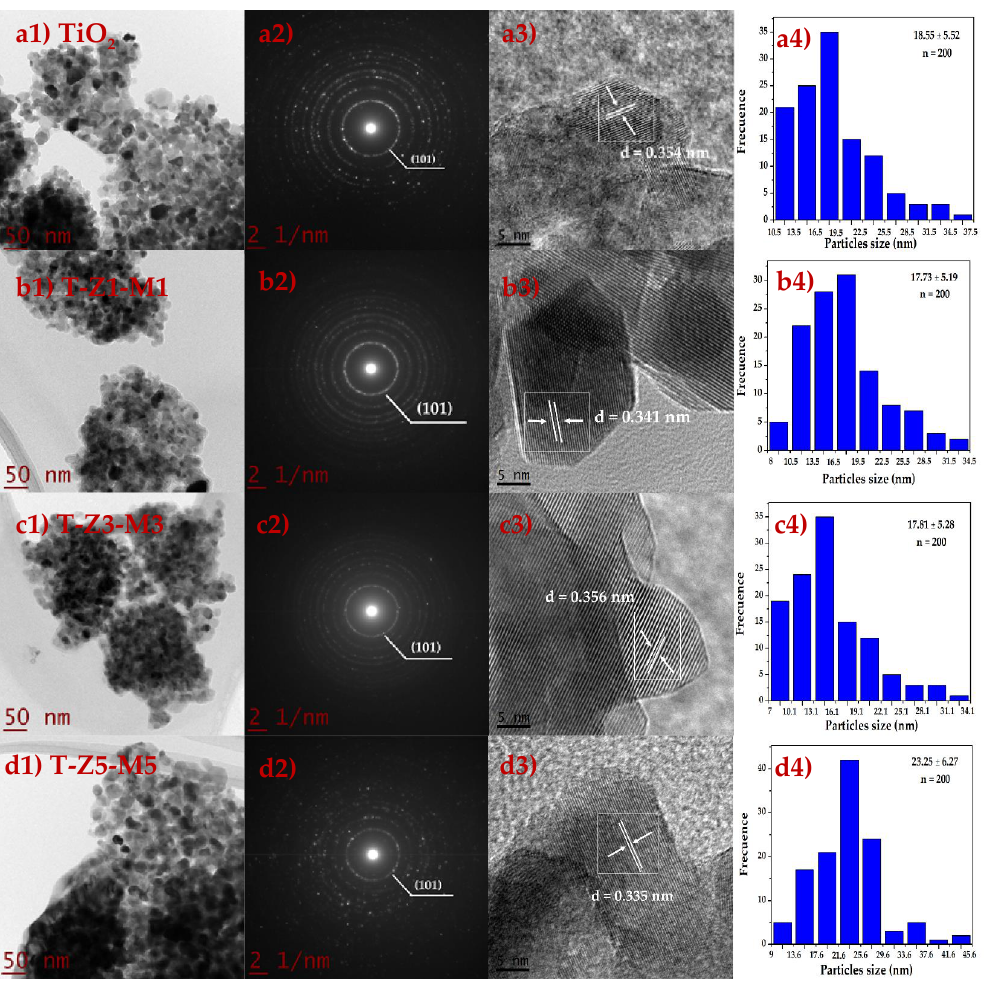
Figure 1. Transmission electron microscopy ( a1 , b1 , c1 , d1 ), selected area electron di ff raction pattern ( a2 , b3 , c2 , d2 ), high-resolution transmission electron microscope ( a3 , b3 , c3 , d3 ) and the size distribution ( d1 , d2 , d3 , d4 ) of pure TiO 2 and mixed oxide materials. T-Z1-M1 is TiO 2 -ZnO (1%)-MgO (1%), T-Z3-M3 is TiO 2 -ZnO (3%)-MgO (3%) and T-Z5-M5 is TiO 2 -ZnO (5%)-MgO